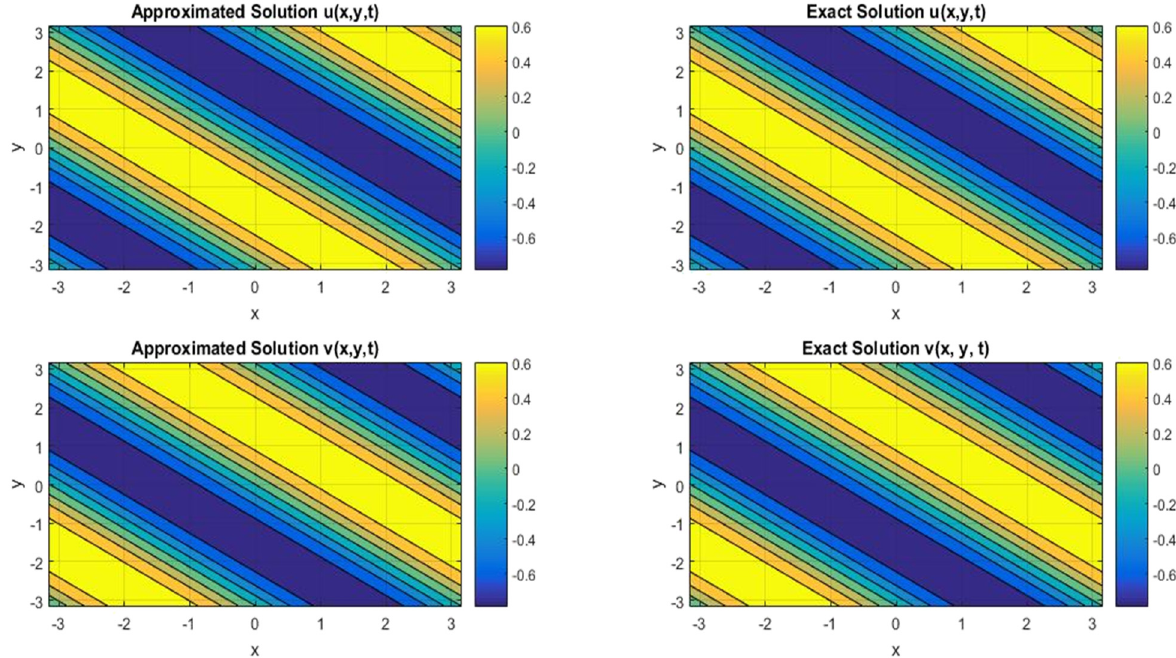
Figure 6: Contour plot for comparison of approximated and exact results at t = 0.1 with ρ = 1 and N = 11 for ϕ and ψ components regarding Example